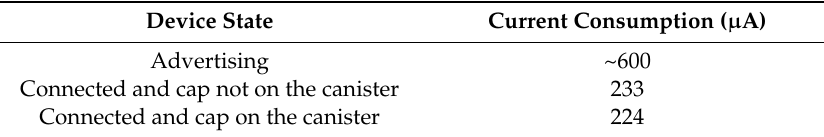
Table 1. Measured current consumption of the device at different states.